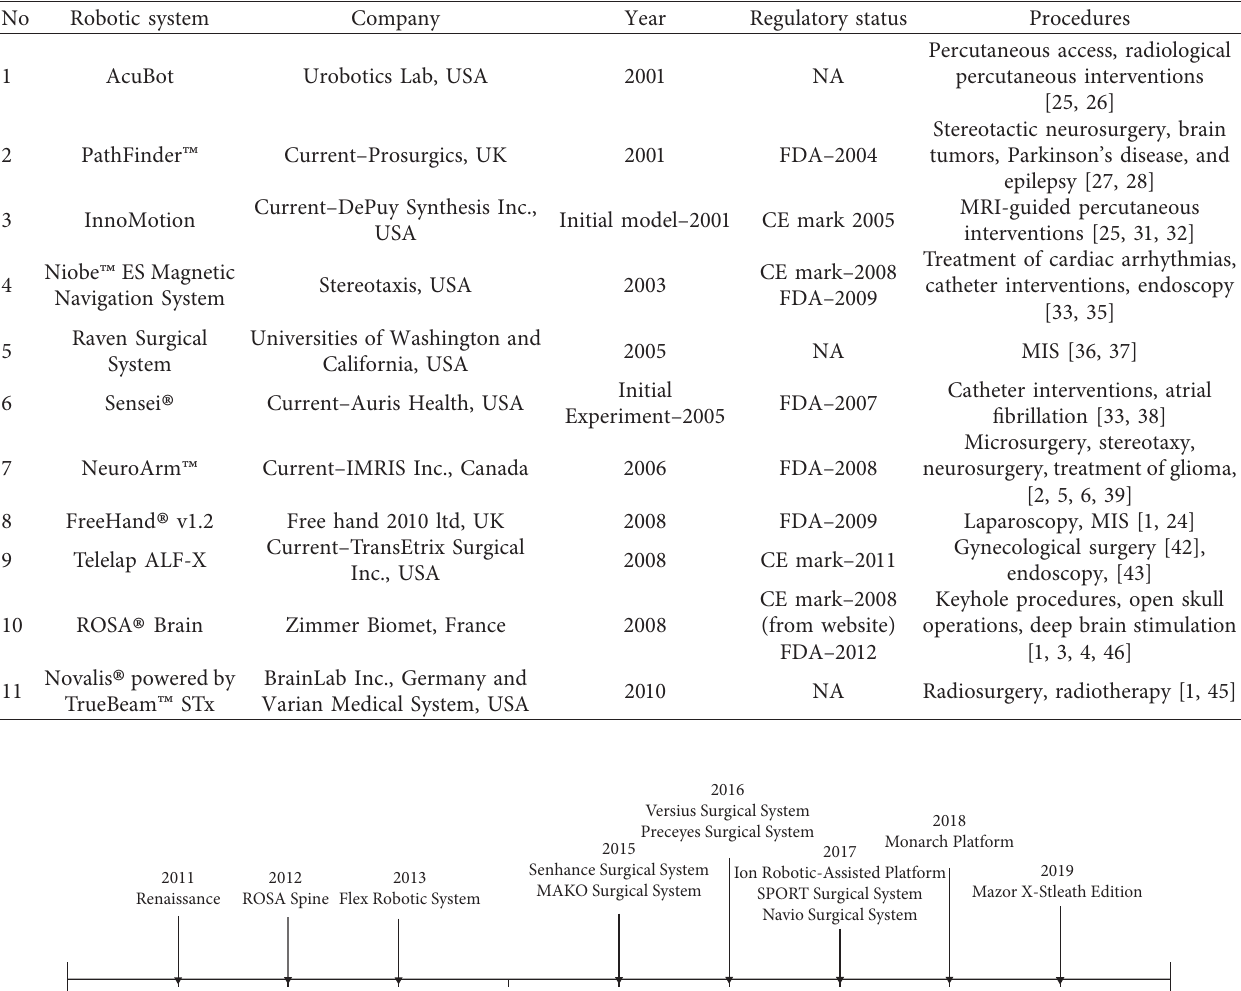
Table 2: Robotic systems that were impactful during decade II, from 2000 to 2010 (middle generations).